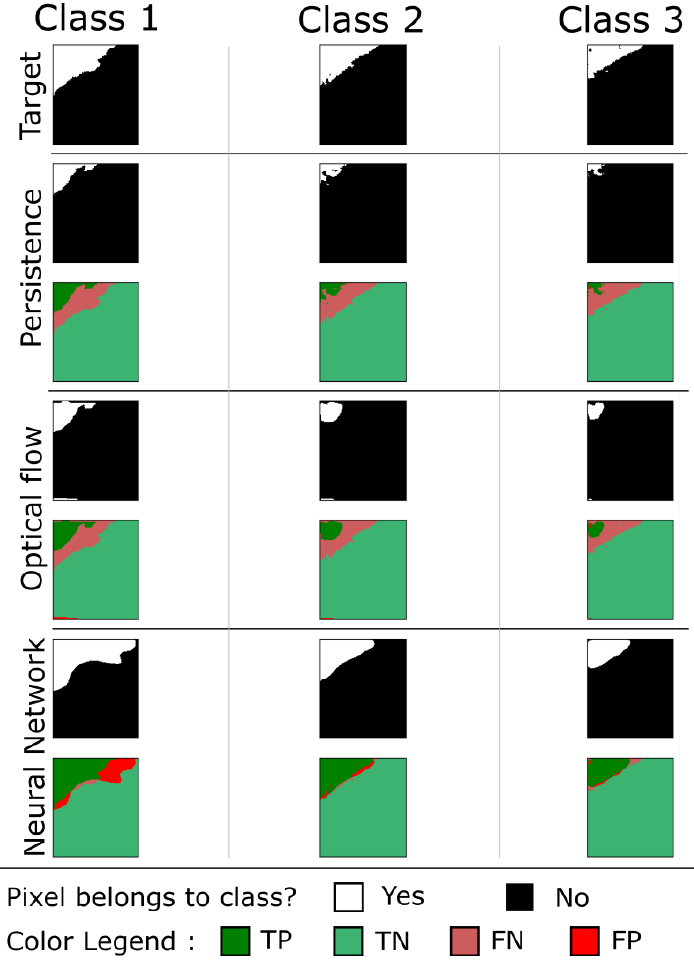
Figure 8. Comparison of forecasts made by different models for a lead time of 30 min. The four rows, respectively, correspond to the target, the persistence, the optical flow, and the neural network. For each forecast, in addition to the raw prediction, the difference to the target is given. The